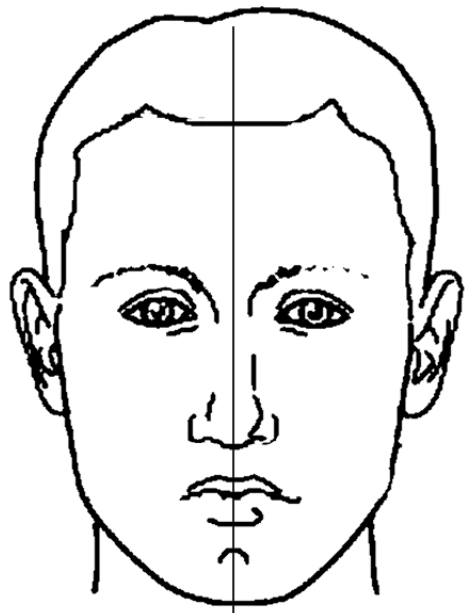
Figure 4. The symmetry axis of the face.